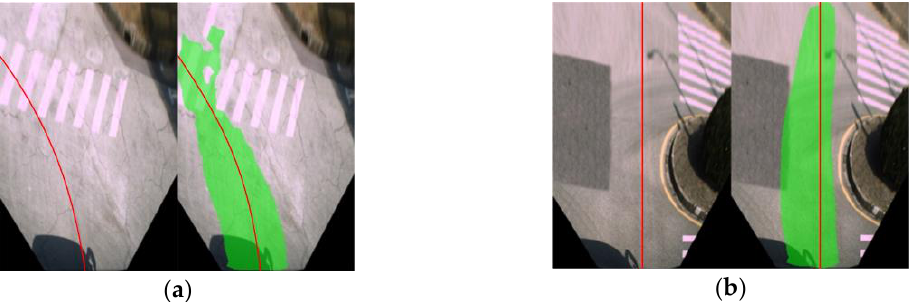
Figure 11. ( a ) Detection results in the presence of large cracks; ( b ) Detection results in the presence of inconsistent pavement colors.